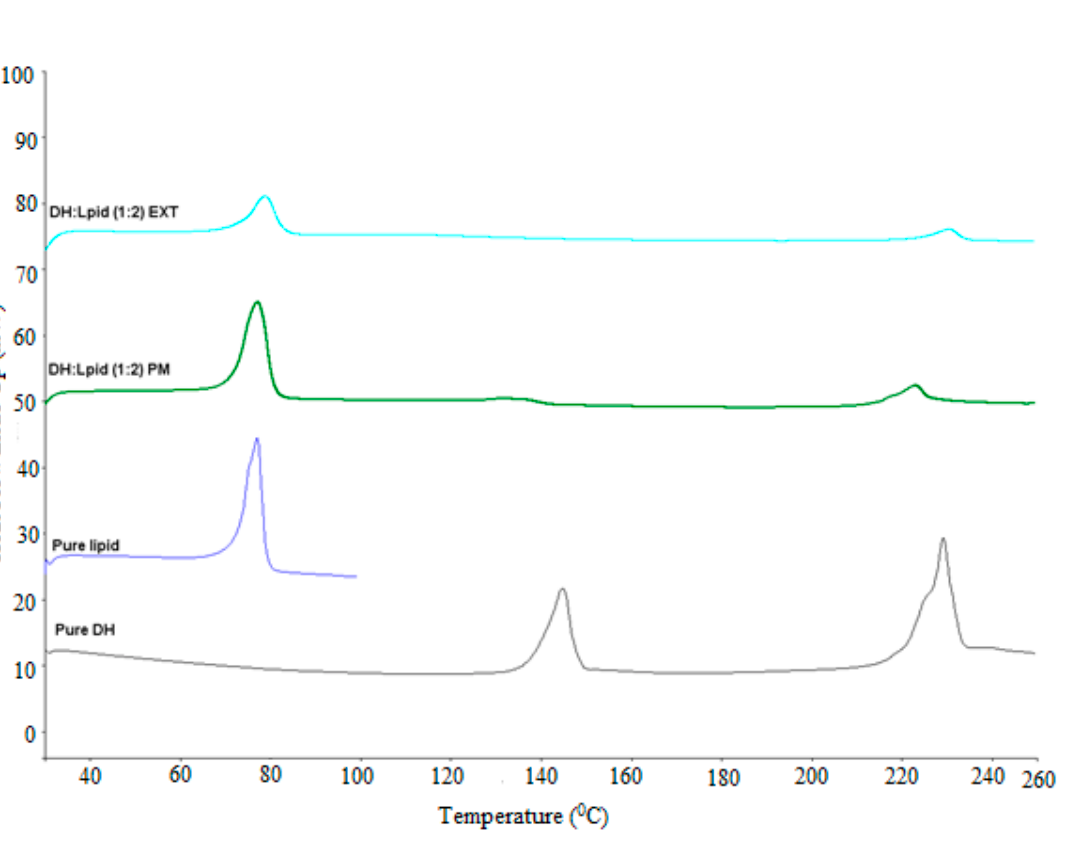
◦ C and a heating rate of 20 ◦ C/min.